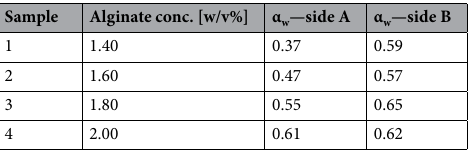
Table 5. Averaged sound absorption coefficient at increasing alginate concentrations.